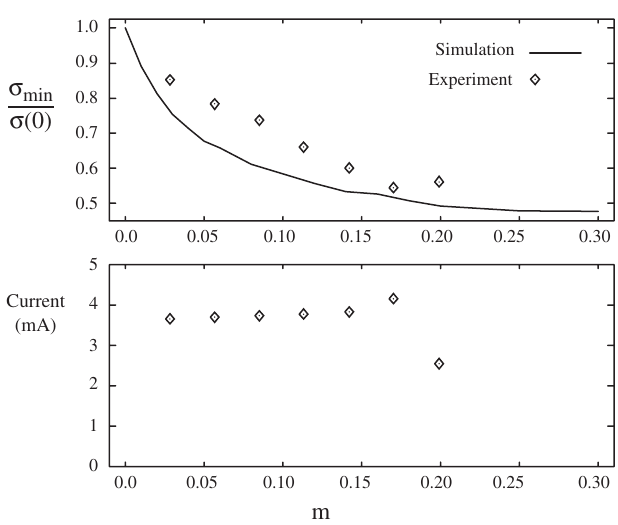
FIG. 18. Bunch compression efficiency and beam current vs modulation strength.